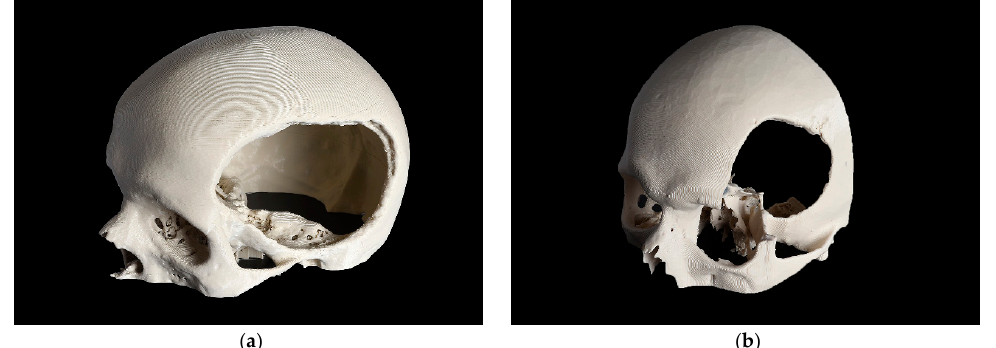
Figure 1. 3D printed skull models with the defect area shown. ( a ) cranial defect (CRD); ( b ) temporo- orbital defect